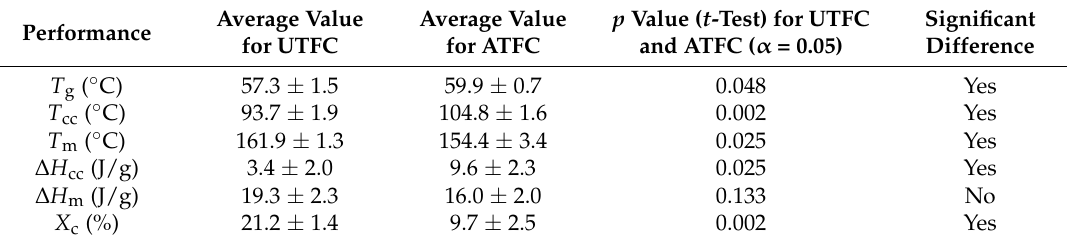
Table 4. Thermal characteristics of composites by